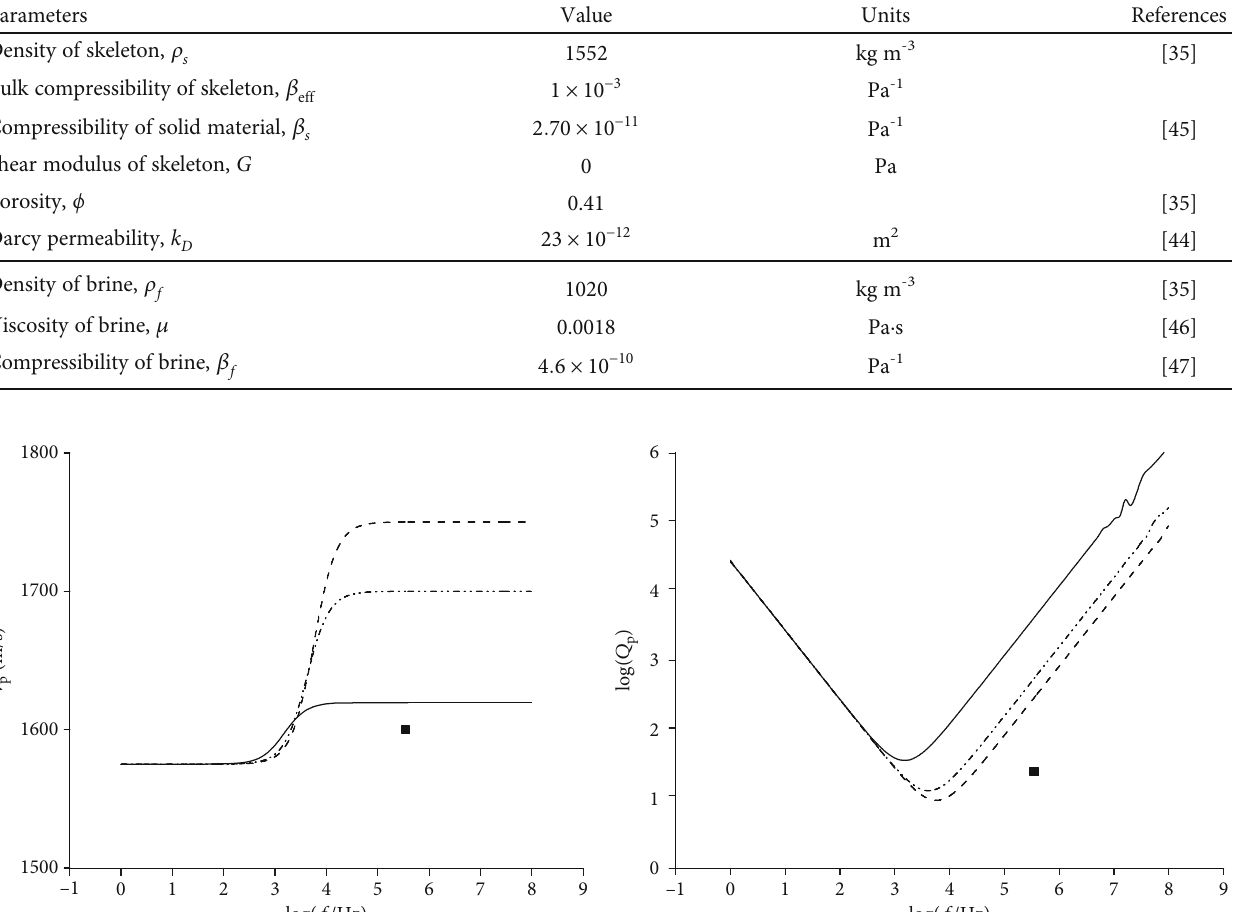
Table 1: Parameters of Toyoura sands saturated with